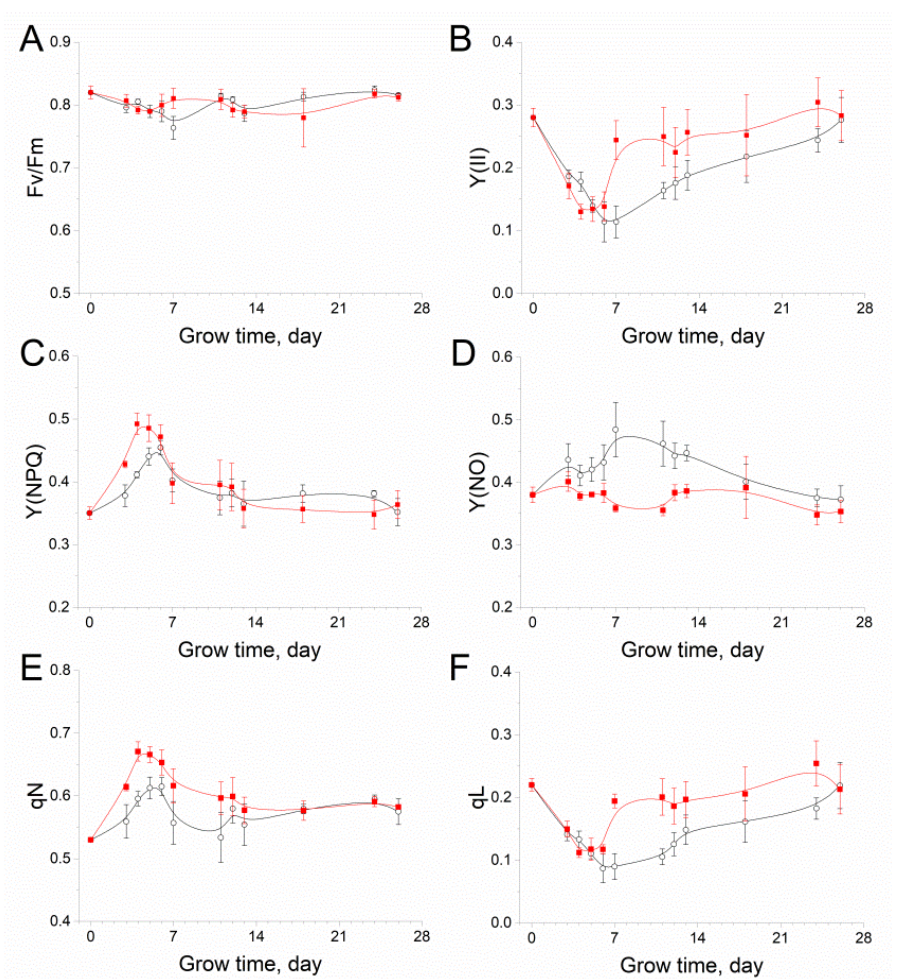
Figure 4. Dependence of maximal Fv/Fm ( A ) and effective Y(II) ( B ) quantum yield of photosystem II photochemistry, quantum yield of light-induced non-photochemical quenching of ChlF (Y(NPQ)) ( C ), quantum yield of nonregulated heat dissipation and fluorescence emission (Y(NO)) ( D ), photochemi- cal (qN) ( E ) and non-photochemical (qL) ( F ) ChlF quenching on grow time of plants under glasses coated with fluoroplate polymer with (closed symbols) or without (opened symbols) photoconversion nanoparticles. The adaptation of samples to actinic light was carried out for 10 min. Measurements were taken at room temperature. The data are the means of at least 3 measurements, with the